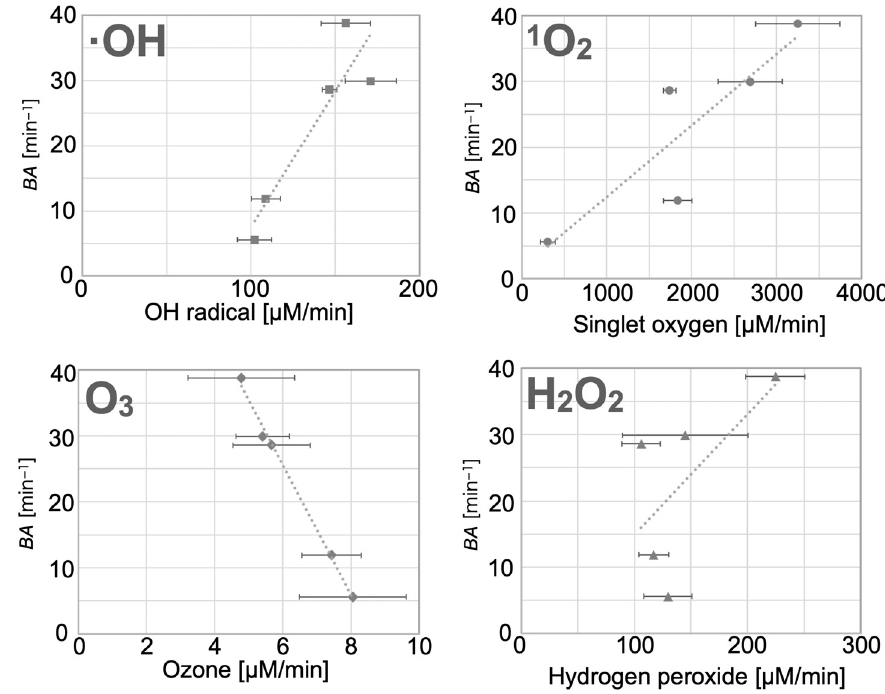
Figure 4. Correlation between bactericidal effect and reactive species in carbon dioxide plasma. Table 2. Correlation coefficient value (R) of BA values and reactive species. Correlation Coefficient Value, R